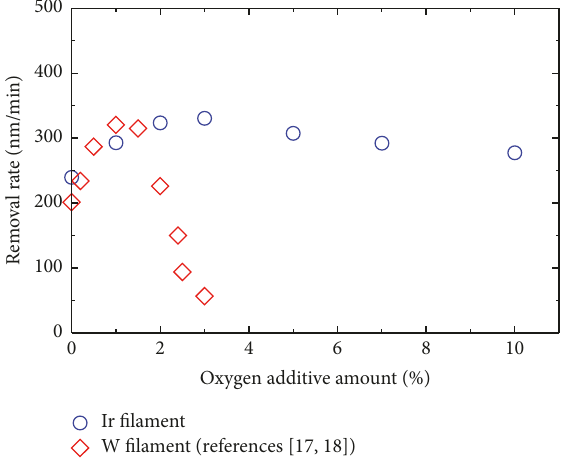
Figure 5: The removal rate as a function of the oxygen additive amount using different filament materials. The filament temperature was 1600 ∘ C and the surface temperature was 280 ∘